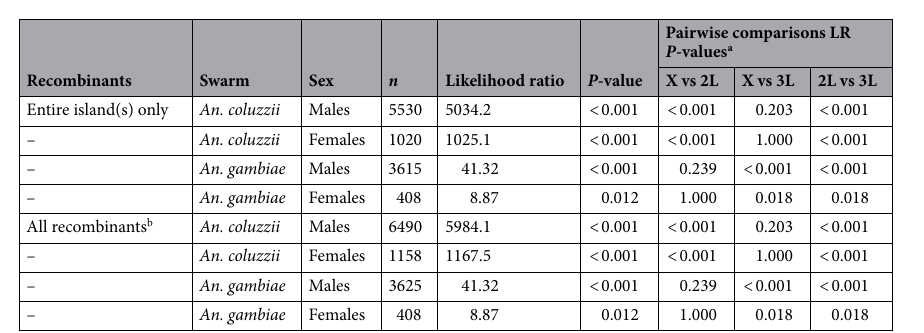
Recombinants Swarm Sex n Likelihood ratio P -value